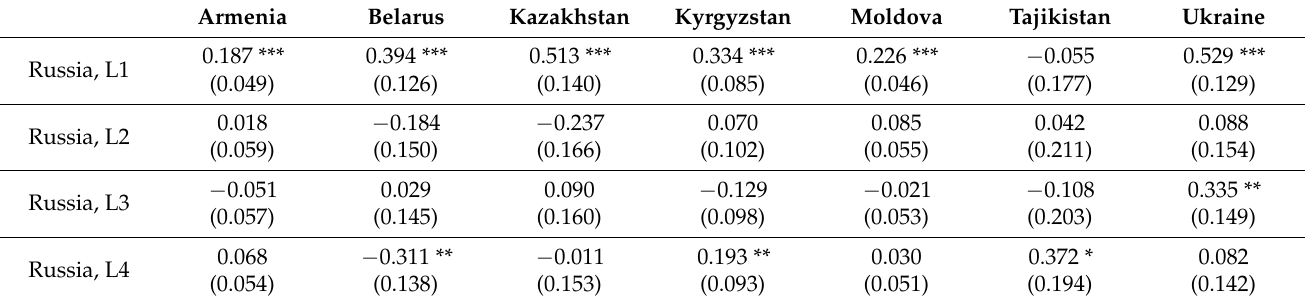
Table 13. Coefficients of Exchange Rates of Ruble as an Independent Variable in the VAR Model.